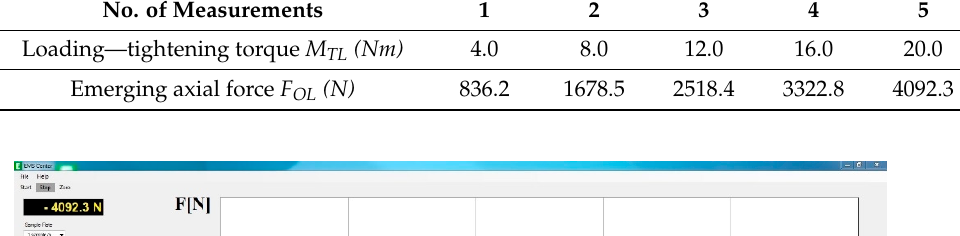
Table 3. Values determined via measurement with lubricant CX80—lithium grease. No. of Measurements